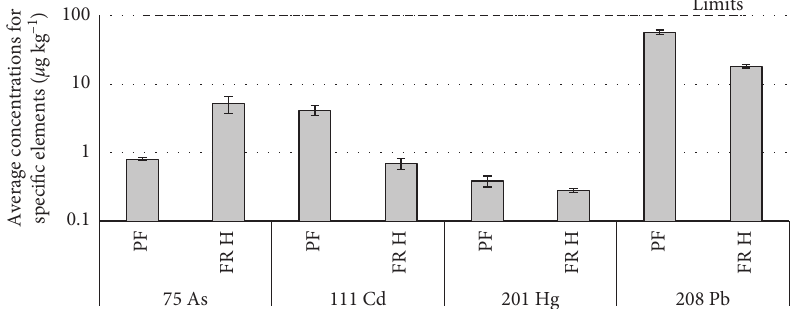
Figure 3: The calculation of average daily intake ( μ g kg − 1 /g/day) of As, Cd, Hg, and Pb from hen eggs according to maximum permissible limits (MPL) established from the FAO/WHO. PF, poultry farms; FR H, free-range